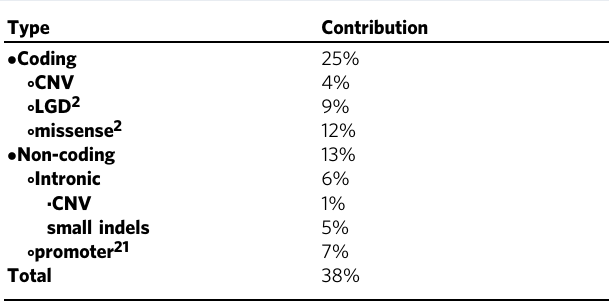
Table 6 De novo contribution to autism in simplex